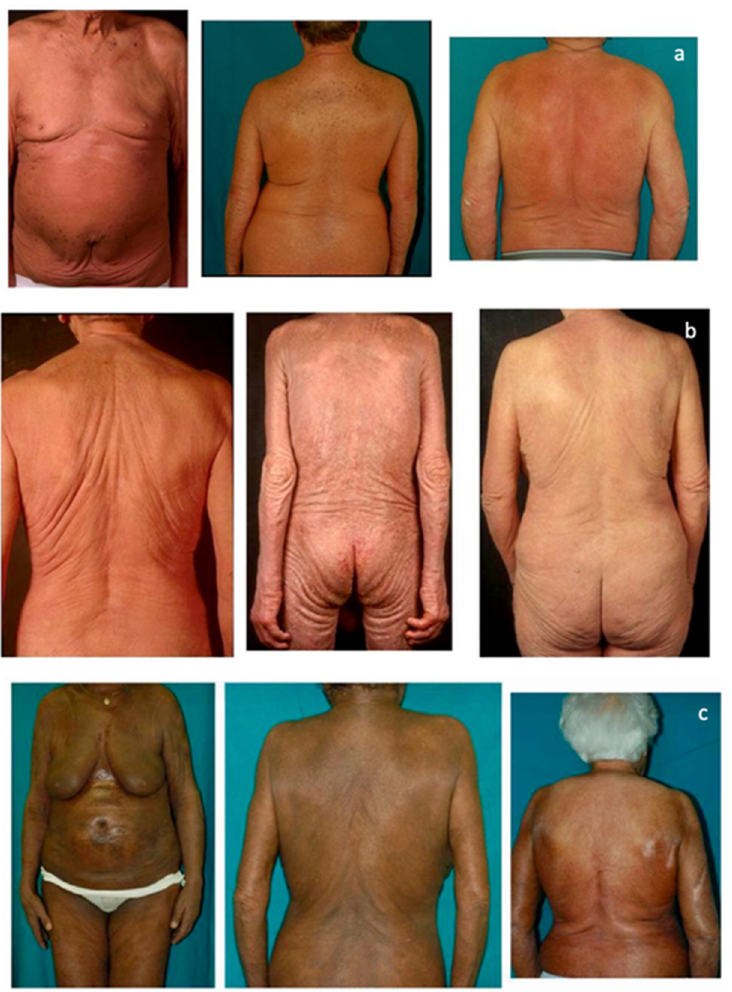
Figure 1. ( a ) The erythematous presentation ( b ) The infiltrative presentation ( c ) The melanodermic presentation.